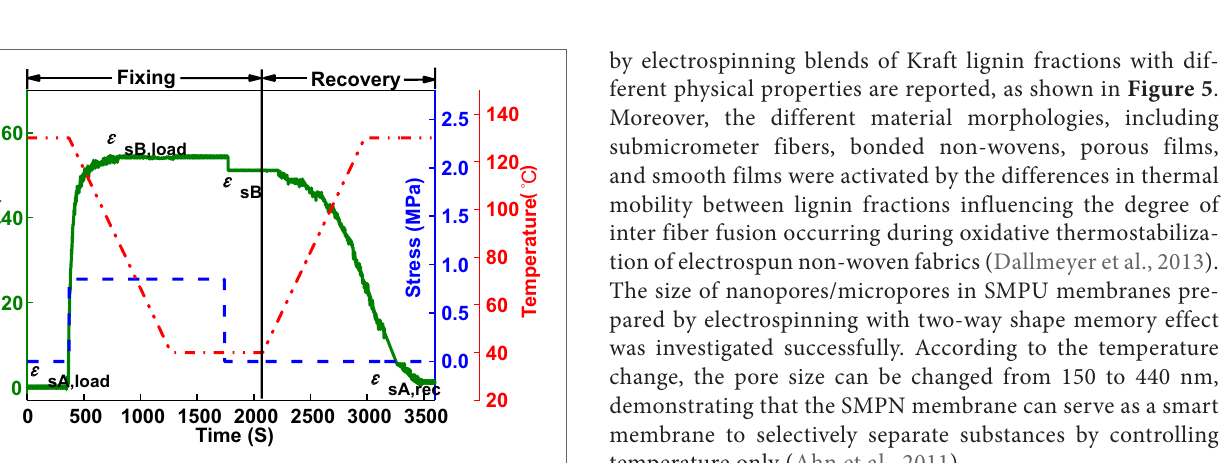
FiGURe 3 | Macroscopic demonstration of the shape memory effect for electrospun fibrous PLMC . (A) Shape recovery process of a spiral in membranous form (2-D); (B) shape recovery process of the cylindrical bars made of electrospun fibers (inset image), in transition from the temporary shape (“SMP”) to the permanent straight bars. Reprinted with permission from Bao et al. (2014). Copyright (2014) American Chemical Society.